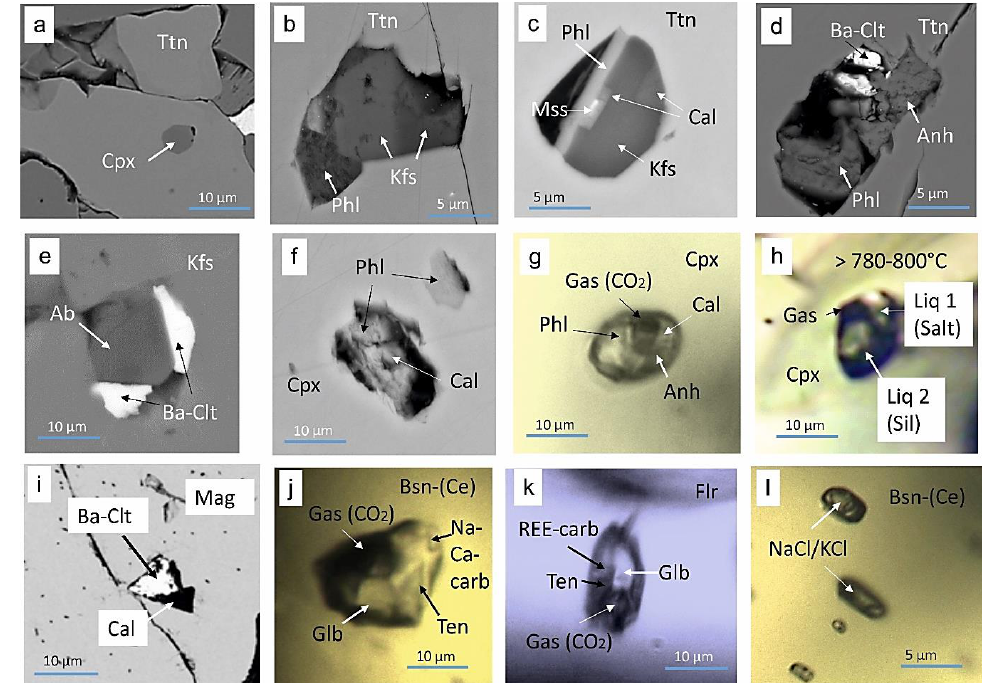
Figure 2. General aspects of inclusions in different minerals comprising carbonatites and associated alkaline magmatic rocks of the Western Transbaikalia carbonatite complexes. ( a – d ) Mineral, melt–silicate, and carbonate–sulfate–silicate inclusions in titanite from shonkinites; ( e ) sulfate–silicate inclusions in K-feldspar from alkaline syenites; ( f ) carbonate–sulfate–silicate inclusions in clinopyroxene from shonkinites of the Khalyuta complex (results from SEM-EPMA analysis). ( g ) Microphotographs of a melt inclusion, including the ( h ) results of thermometric studies of melt inclusions in shonkinite clinopyroxene (Khalyuta); ( i ) SEM-BSE image of a polymineral inclusion in magnetite from the Yuzhnoe carbonatite; ( j ) microphotograph of brine–melt inclusions in bastnaesite-(Ce); ( k ) microphotograph of brine–melt inclusions in fluorite; and ( l ) microphotograph of gas–liquid inclusions in bastnaesite-(Ce) from Ulan-Ude carbonatites. The Raman spectra for the crystalline phases of brine–melt